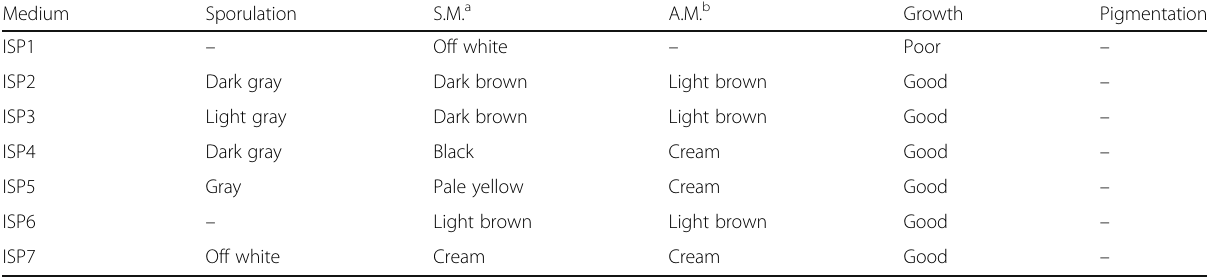
Table 1 Cultural characteristics of strain TES17 on various media